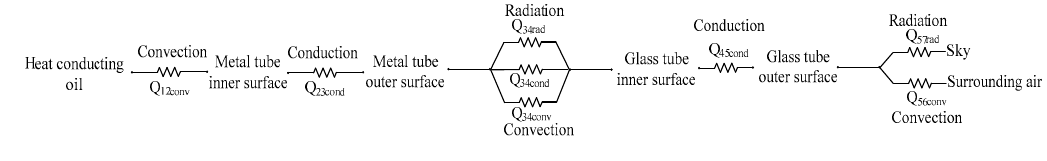
Figure 3. Thermal resistance model.